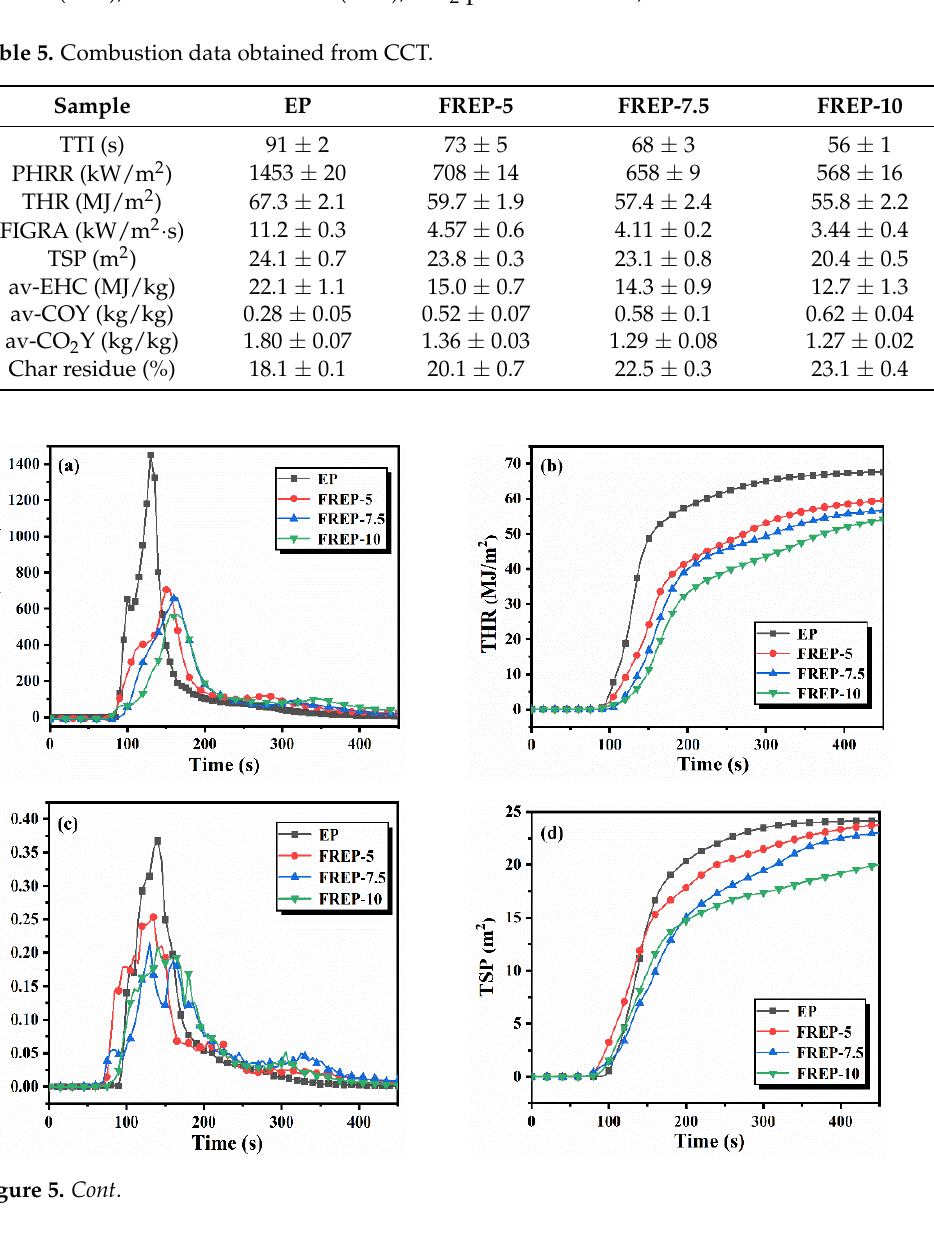
Table 4. UL-94 Flammability Ratings and LOI Values for EP Composites.